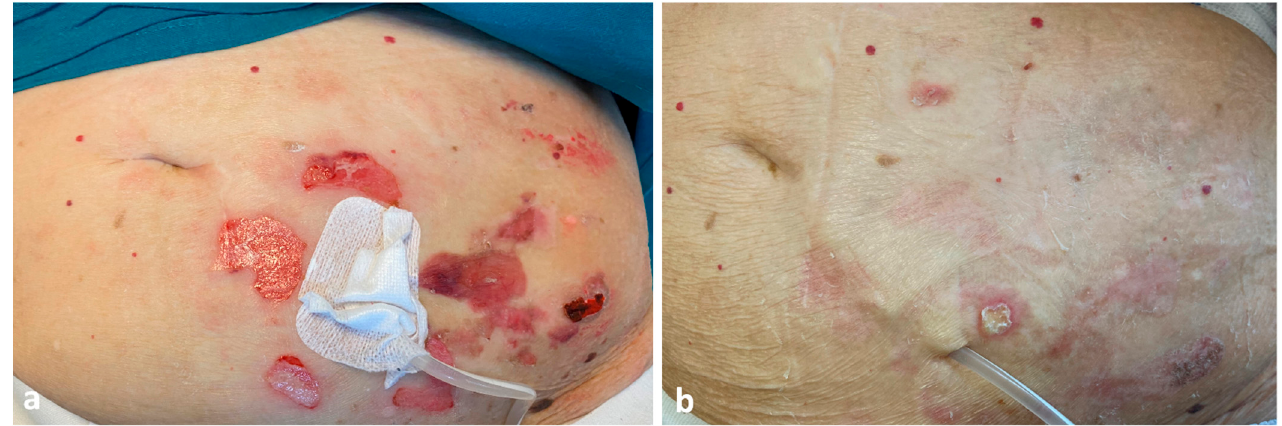
Figure 3. Healing erosions without new blisters around the peritoneal dialysis catheter exit site after two weeks of therapy ( a ). Resolved/healed skin lesions six weeks later ( b ).